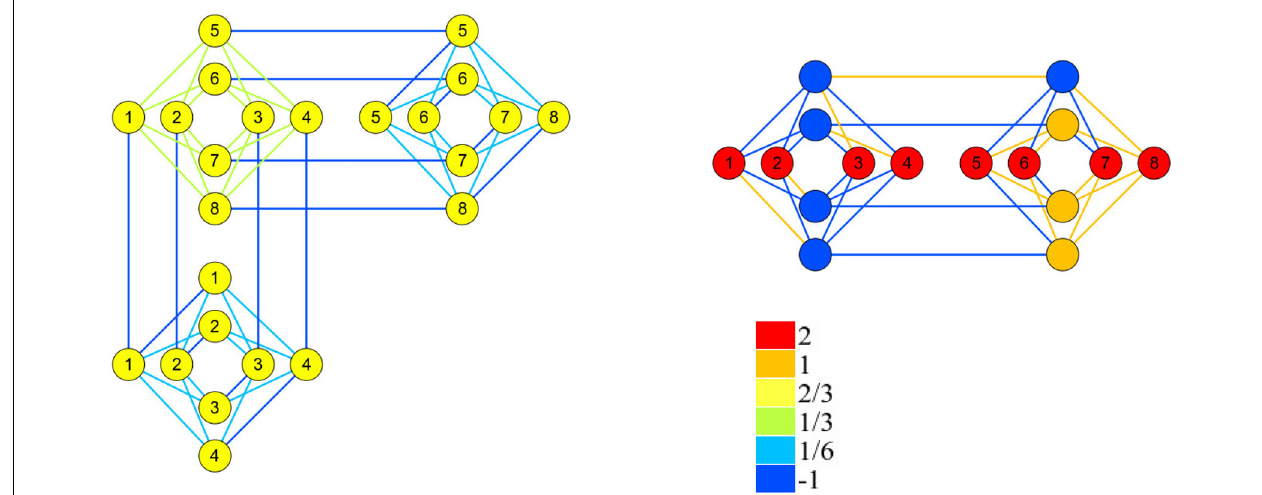
(cid:2) 8 = − 6. The values are indicated by node colors, and θ i , j values by edge colors. i = 1 s i The node labeled i corresponds to variable s i , and unlabeled nodes are